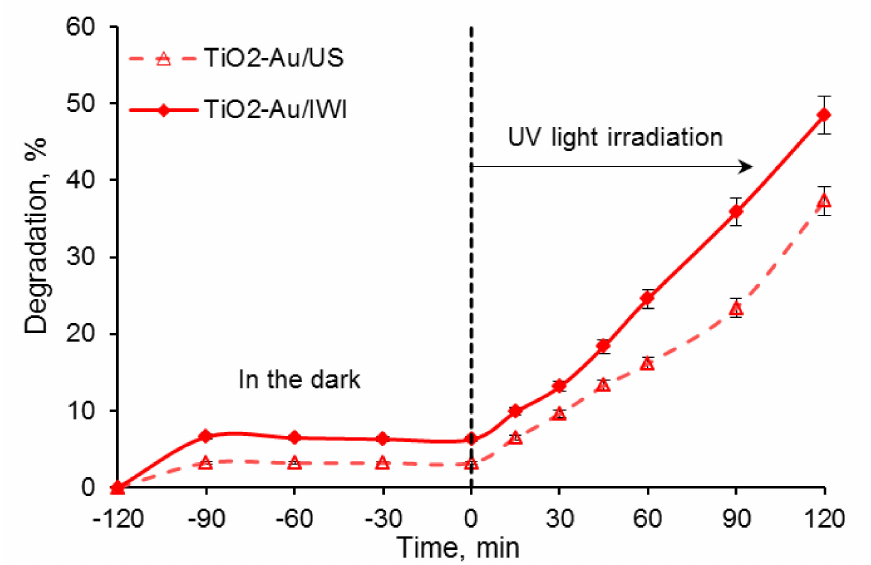
Figure 6. 2,4 dinitrophenol (2,4 DNP) degradation (20 mg/L) in the presence of the TiO 2 -Au (1 g/L) catalysts, obtained by US and IWI